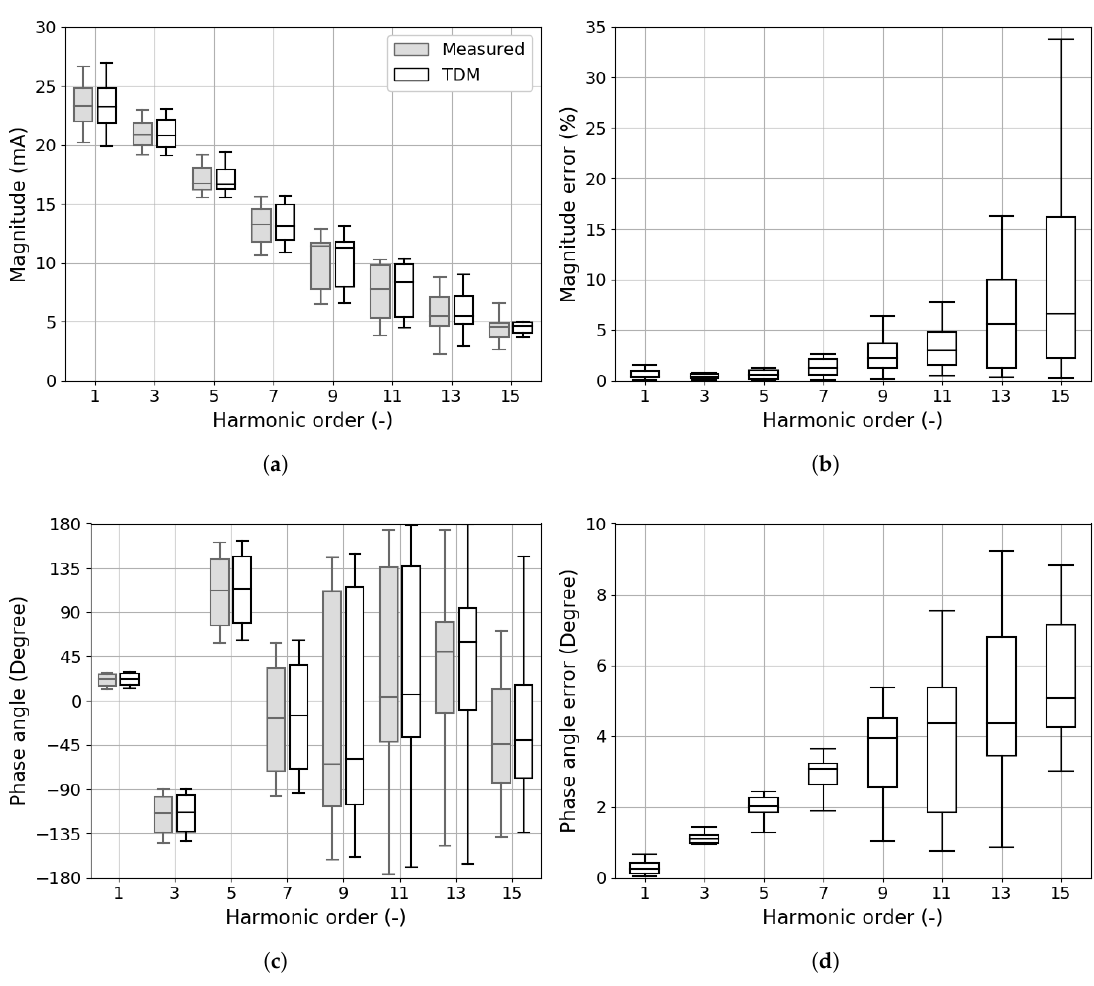
Figure 4. LED Type A: Comparison of the time-domain model (TDM) and the measured data for all test points: ( a ) Magnitude; ( b ) Magnitude error; ( c ) Phase angle; and ( d ) Phase angle